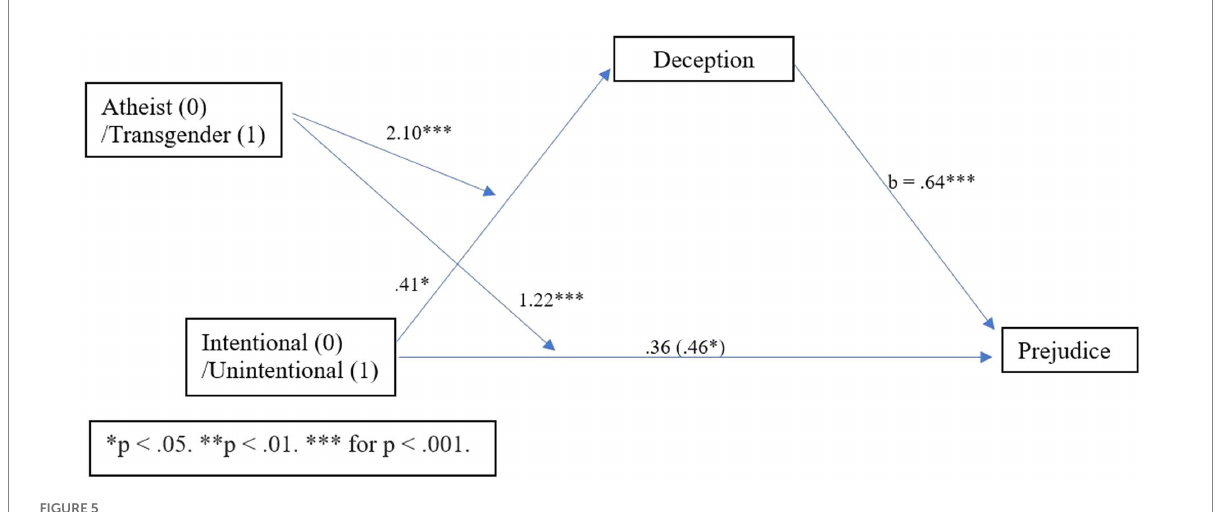
FIGURE 5 Process Model 8 moderated mediation with deception Study